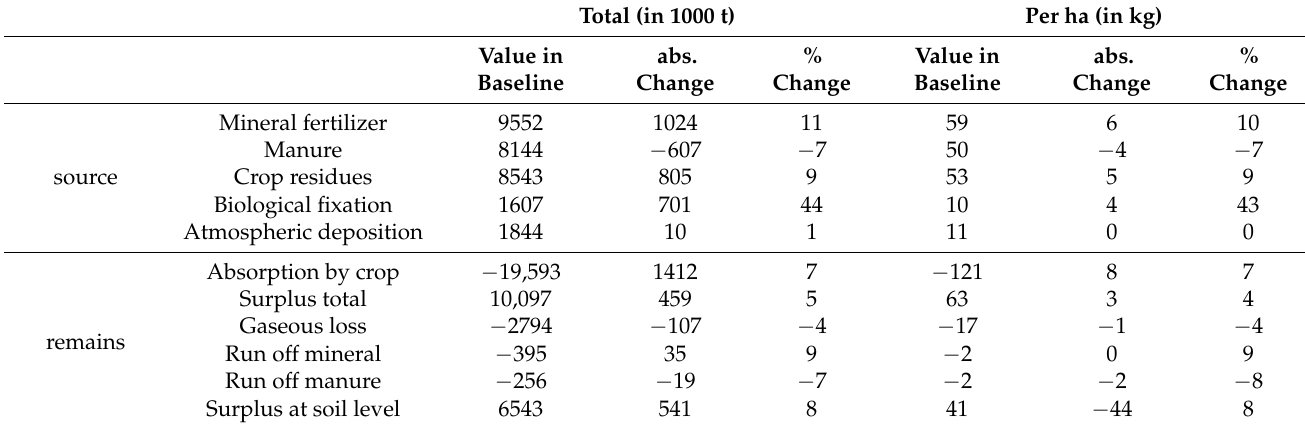
Table 6. Sources and remains of nitrate used in the EU agriculture.